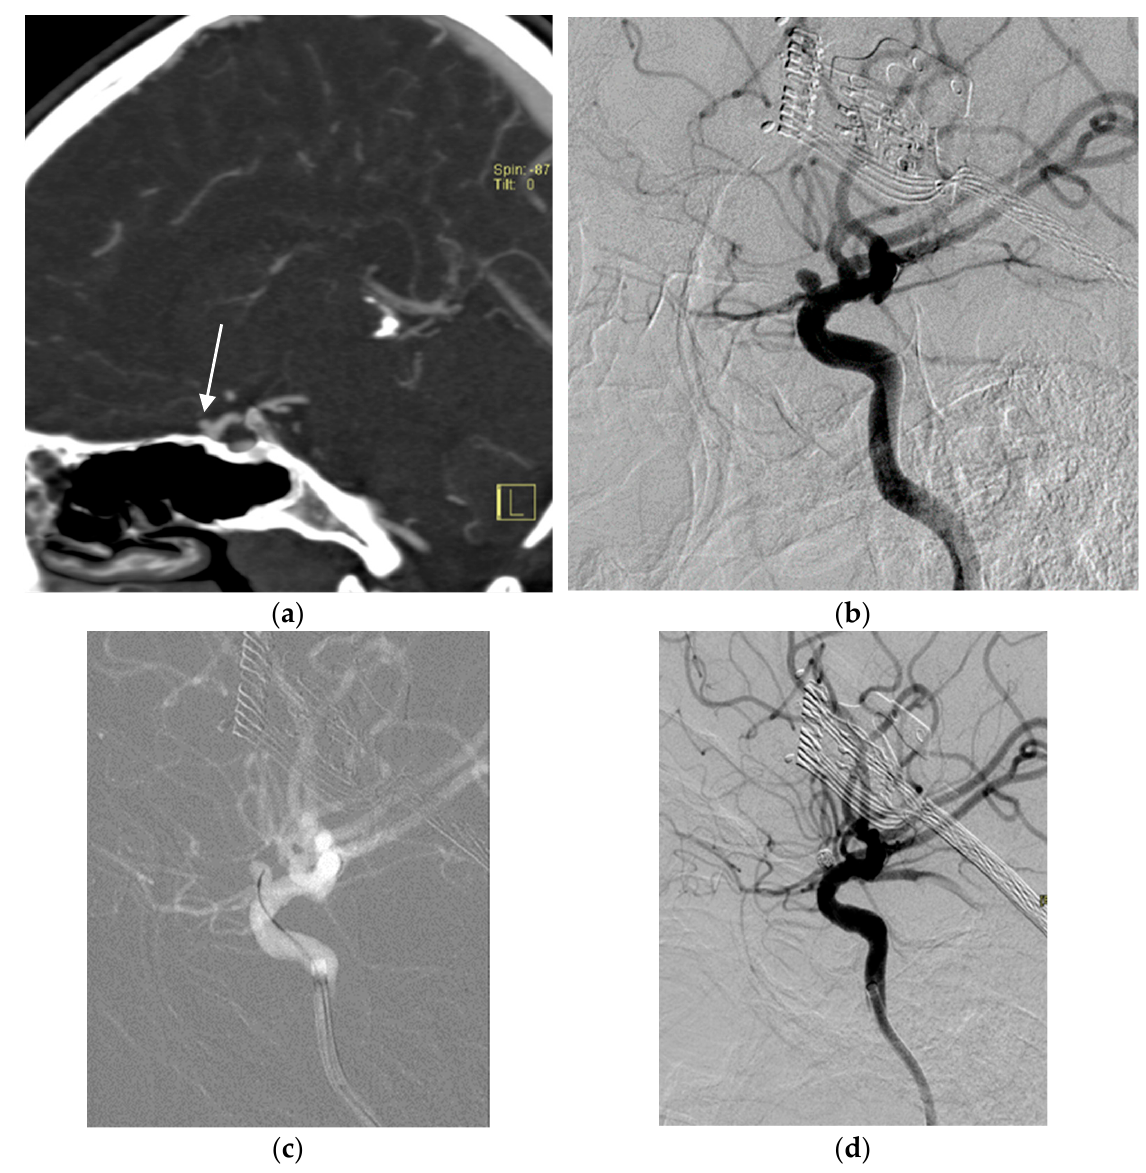
Figure 4. A case of intracranial aneurysm in a 16-year-old female. The CTA showed a 3 mm saccular aneurysm in the ophthalmic segment of the internal carotid artery (arrow, ( a )). The DSA image confirms the aneurysm ( b ), which is subsequently treated with coils ( c ). The control DSA shows the excluded aneurysm ( d